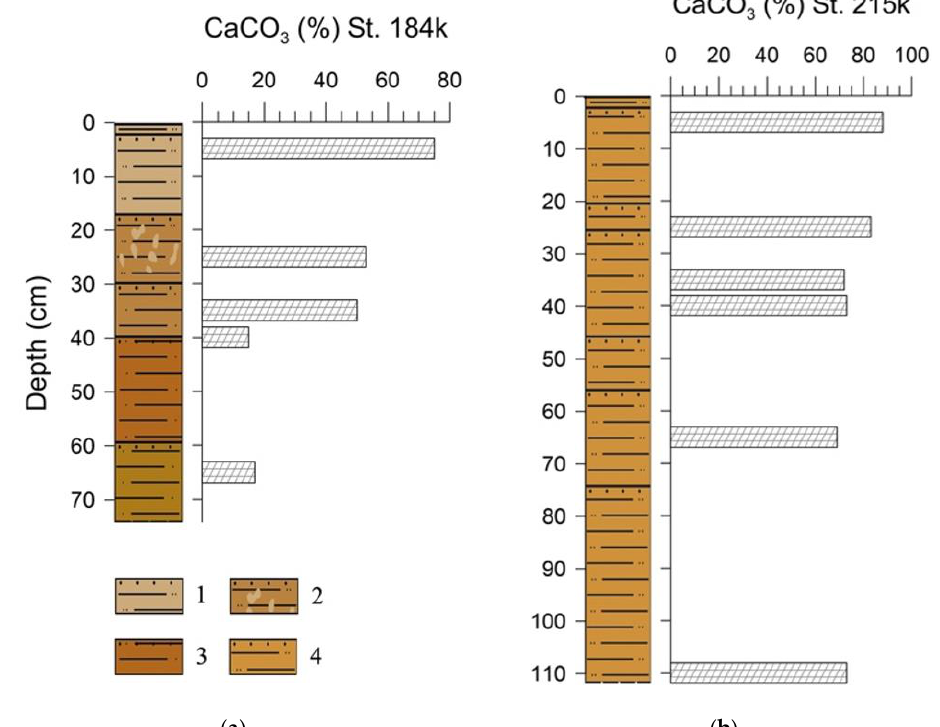
Figure 2. Lithology and the CaCO 3 contents in sediment cores 184k ( a ), and 215k ( b ). Legend: 1— coccolite-foraminiferal, light-brown soft ooze, with sandy admixture; 2—coccolite-foraminiferal, light-brown, dense, silty-pelitic ooze, with bioturbation patches; 3—homogenous coccolite-foraminiferal, dark-brown silty-pelitic ooze; 4—homogenous coccolite-foraminiferal, light-brown, dense, silty-pelitic ooze with sandy admixtures. Table 1. The total organic carbon (TOC), total inorganic carbon (TIC), and some major elements in the bulk sediments of 184k and 215k cores from the hydrothermal cluster Pobeda.